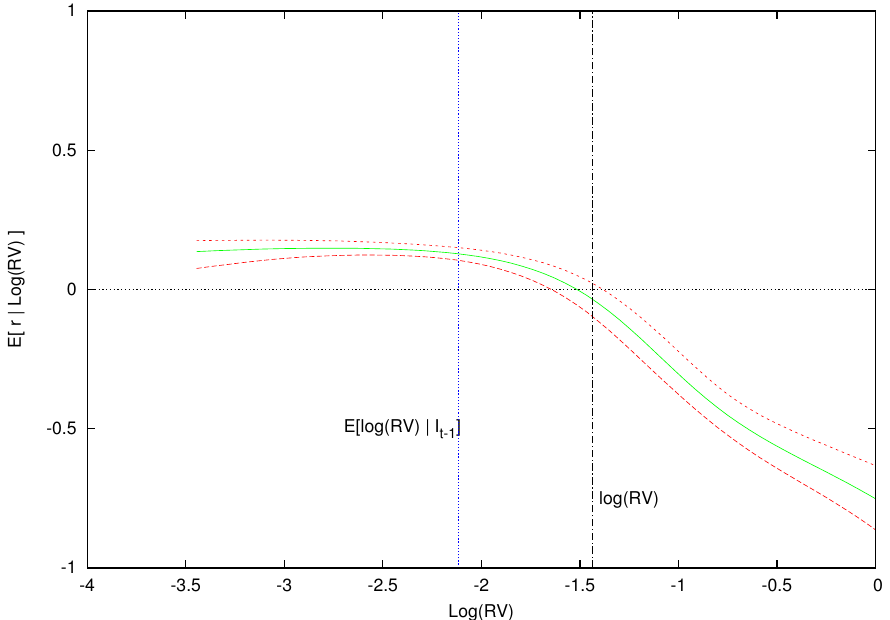
Figure 5. Expected excess return given log realized variance for the information set I t − 1 where volatility is near its average level. This figure displays the expected excess return and 0.90 density intervals as a function of log ( RV ) conditional on regressors in the information set from I t − 1 , t = 1996 : 2, which is an average volatility period. The expected log-realized volatility based on the model is blue while the actual log-realized volatility for t = 1996 : 2 is the black vertical line.